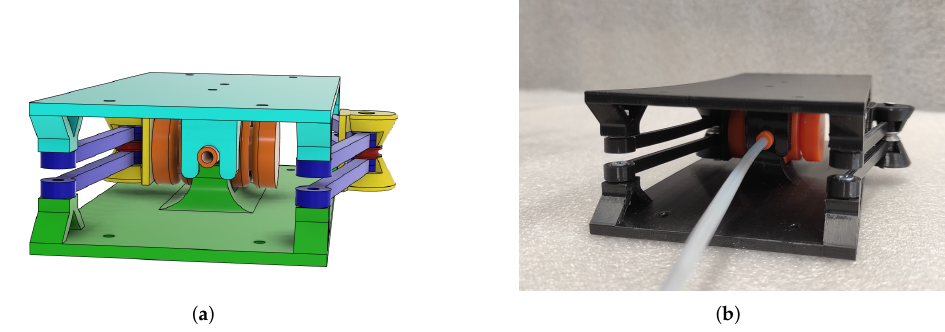
Figure 5. Mechanism assembly. ( a ) 3D view in Autodesk Fusion 360 CAD-3D software. ( b ) Real